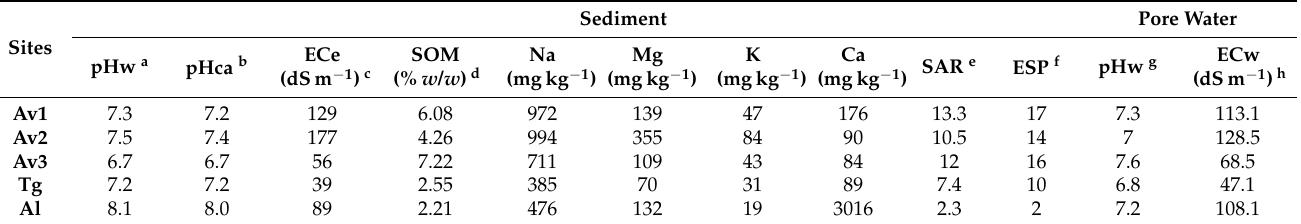
Table 1. Physico-chemical properties of sediments and pore water at Ria de Aveiro (Av), Tagus estuary (Tg) and Almargem (Al)